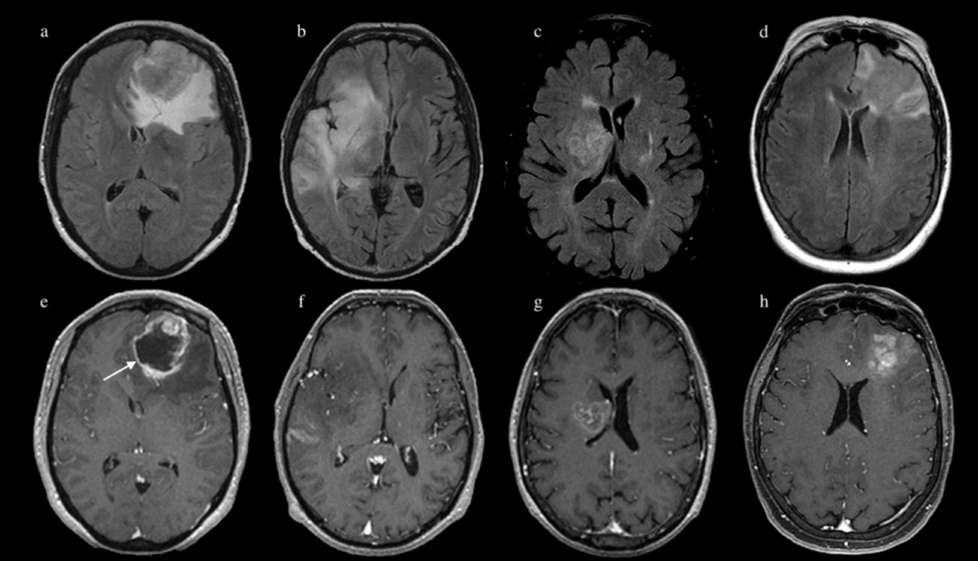
Figure 1. FLAIR images (above) and post-contrast MPRAGE images (below) of four patients with glioblastoma multiforme (GBM) from our cohort. Patient 1 ( a , e ) presented an expansile left frontal lobe GBM with typical features of rim-enhancement and central necrosis (arrow on image e); pathology confirmed isocitrate dehydrogenase (IDH)-wildtype. Patient 2 ( b , f ) presented a diffuse non-enhancing infiltrative GBM of the right temporo-insular region; pathology confirmed IDH mutation. Patient 3 ( c , g ) and 4 ( d , h ) demonstrated ‘borderline’ features, not typical for any IDH status; pathology confirmed IDH mutation for patient 3 and IDH-wild type for patient